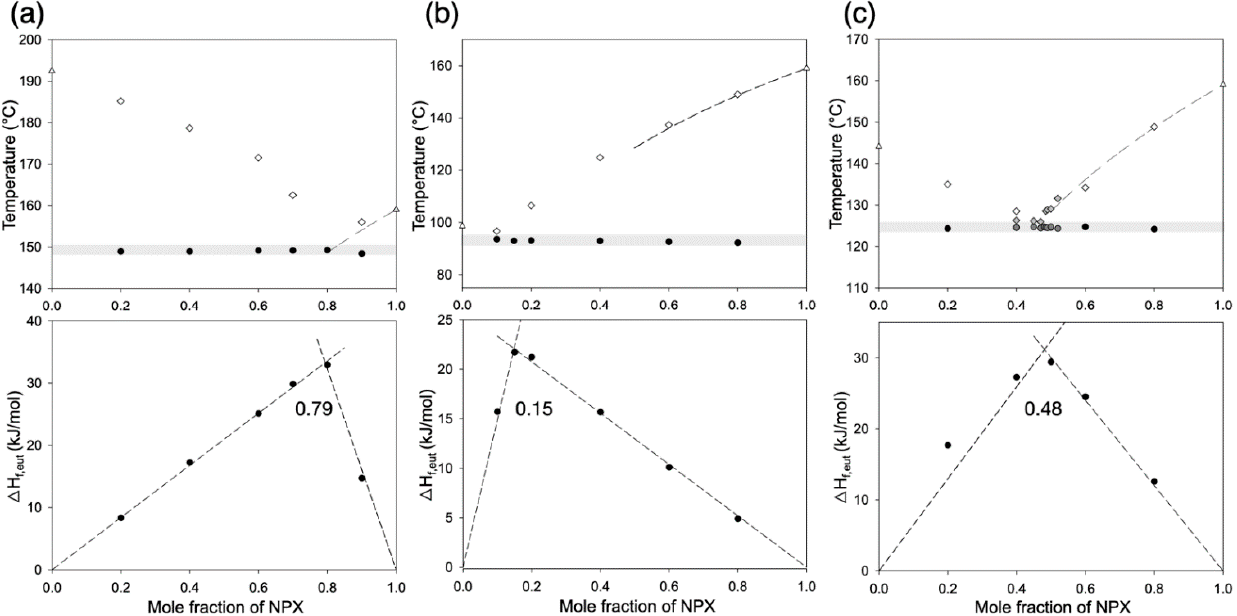
Figure 2. Melting diagrams and Tammann plots of ( a ) NPX/SUC, ( b ) NPX/GLU, and ( c ) NPX/SUB mixtures. Dashed lines in melting diagrams represent the ideal behaviors calculated using the van ’t Hoff equation. A heating rate of 10 °C/min was used for the overall construction of the diagrams (empty triangles for the melting points of pure components; empty diamonds liquidus temperatures; filled black circles solidus temperatures). A heating rate of 1 °C/min (gray diamonds and dark gray circles for the liquidus and solidus temperatures, respectively) was used to determine the eutectic composition of NPX/SUB more accurately as 0.48:0.52. In Tammann plots, eutectic compositions (mole fraction of NPX = 0.79, 0.15, and 0.48, respectively) were predicted as the intersections of the extrapolated lines of the enthalpy of eutectic melting ( ∆ H f,eut ), obtained from the deconvolution of the DSC thermograms (heating rate 10 °C/min). Note that similar time-consuming (1 °C/min) verification for the exact composition NPX showed eutectic compositions with all three dicarboxylic acids (SUC, GLU, was not performed for the NPX/GLU and NPX/SUC, because their eutectic mixtures were